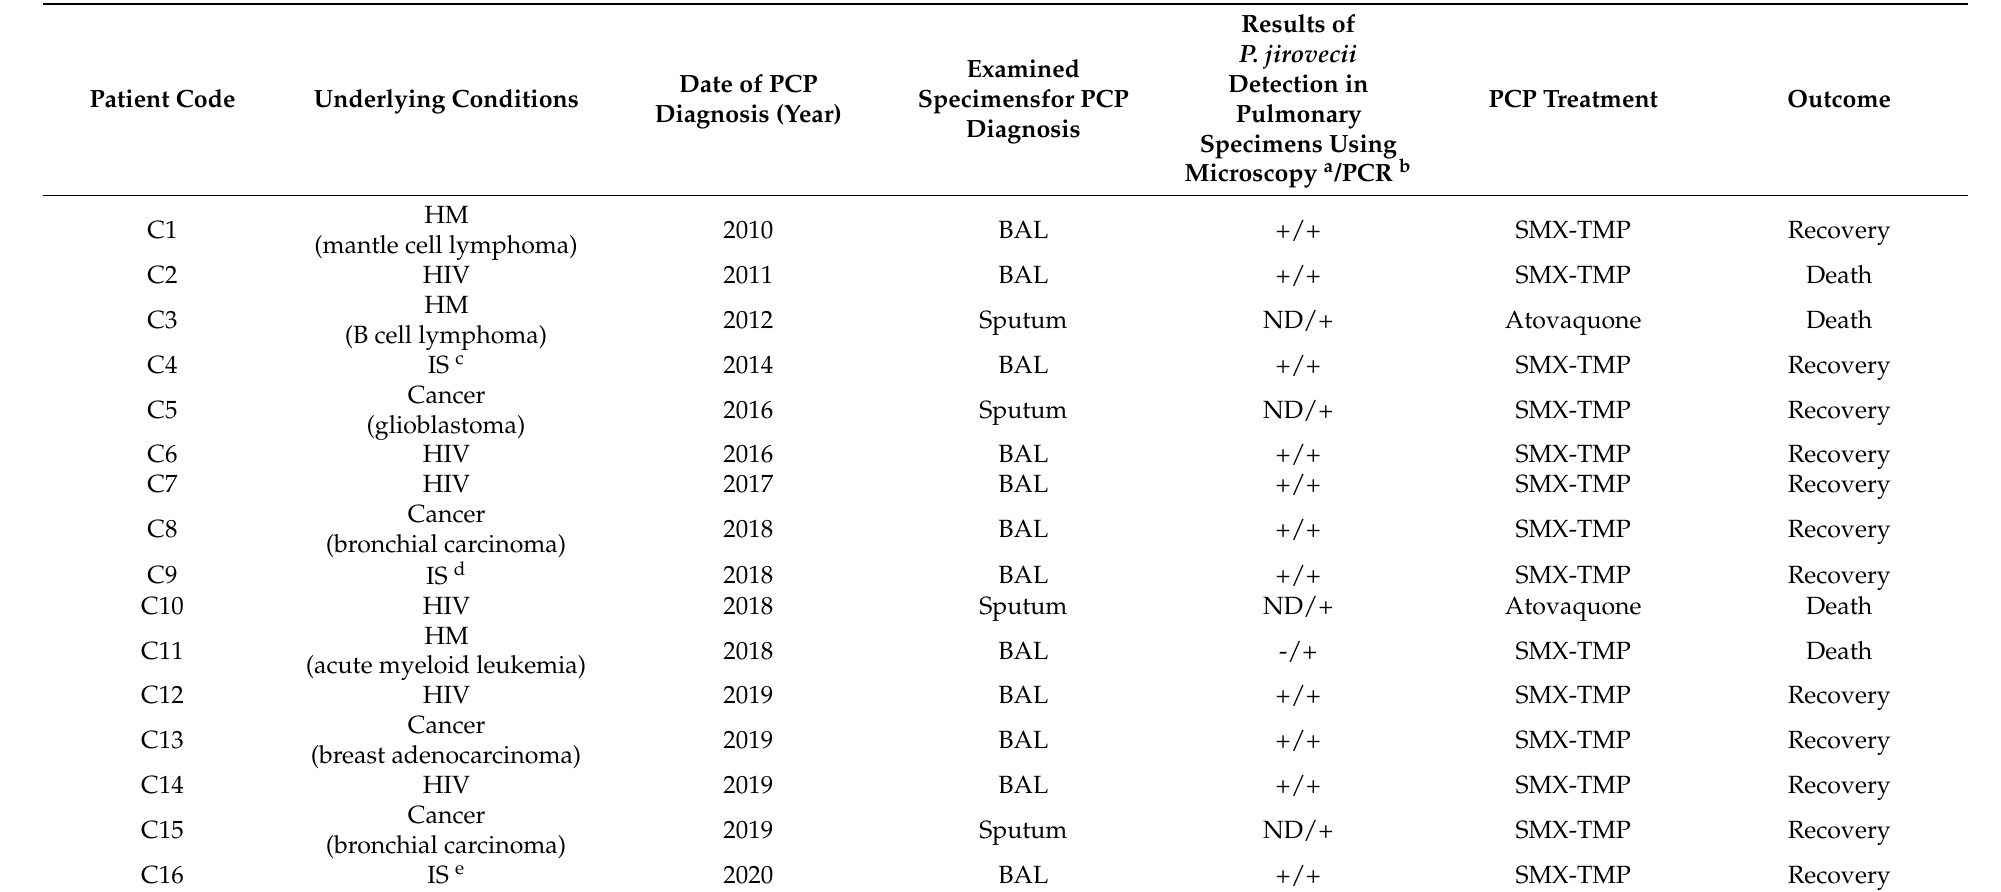
Table 2. Characteristics of the 16 control patients without prior exposure to mycophenolic